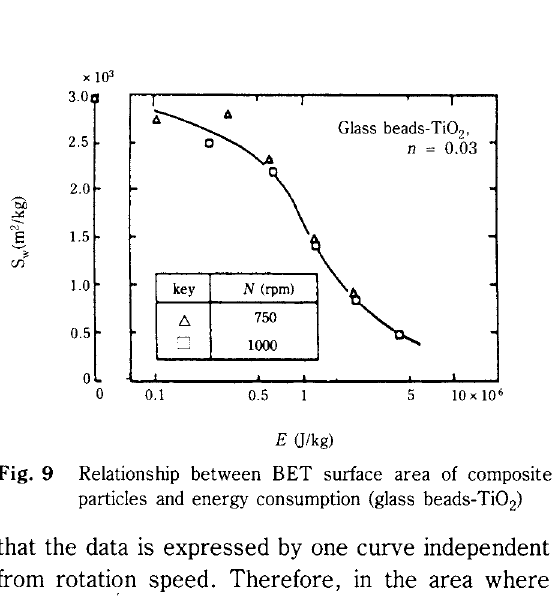
Fig. 10 Relationship between BET surface area and energy consumption of four kinds of apparatus indicated in Table 1 (silica sand-Ti0 2) the data can be arranged on one curve without referring to the size of the apparatus and its opera tion conditions. This implies that the scale-up of the apparatus can be done by the relation shown in Fig. 10. It is necessary to have further studies hereafter on this point, including the measurement of R